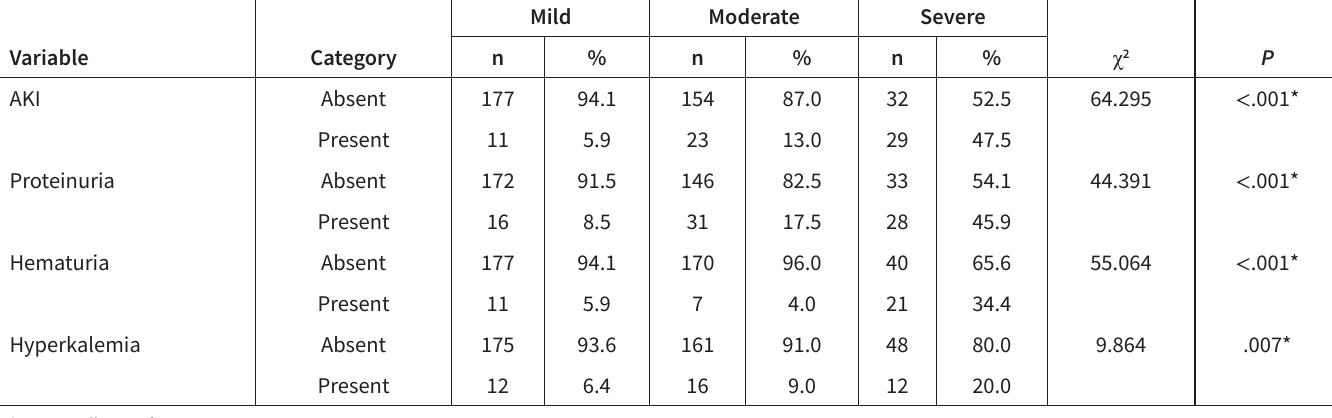
Table 4. Comparison of Various Stages of AKI, Proteinuria, Presence of Hematuria, and Hyperkalemia with Severity of COVID-19 Using Chi-Square Test